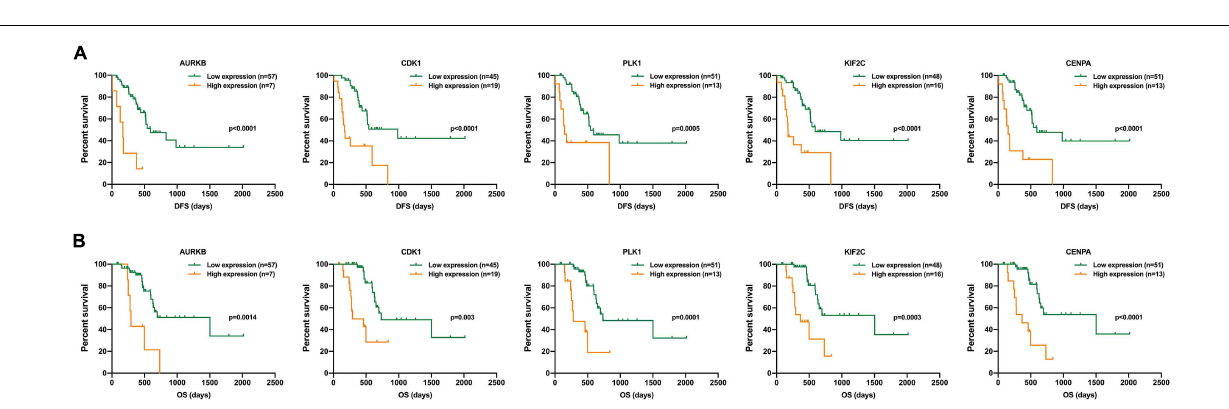
FIGURE 8 | Survival analysis of the top five genes in the purple module. (A) OS analysis of the top five genes. (B) DFS analysis of the top five